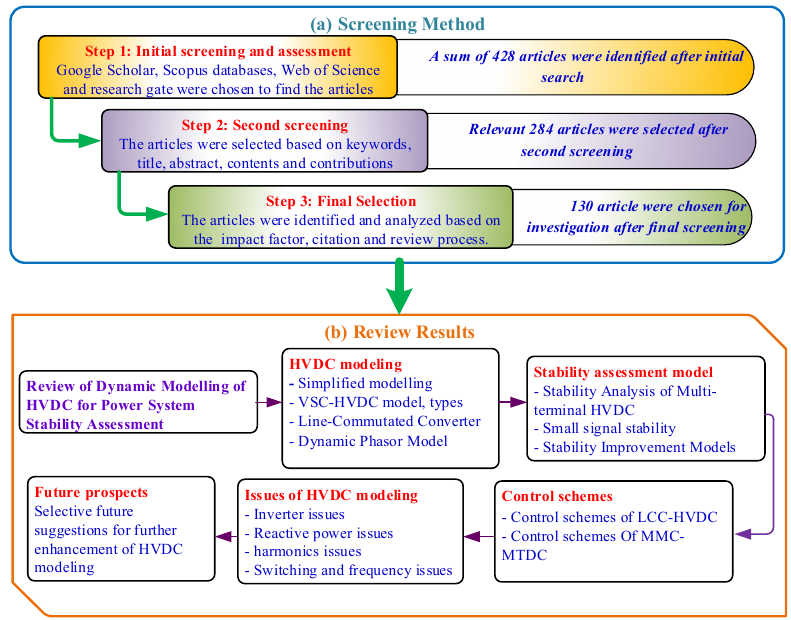
Figure 1. Schematic design of the reviewing methodology ( a ) Screening method ( b ) Review results.